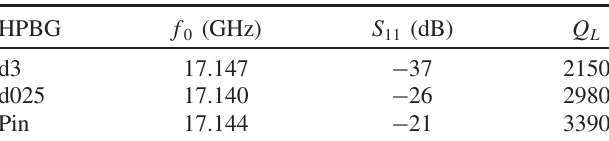
TABLE V. Comparison of f 0 and Q L of the three HPBG structures in S 11 measurement.